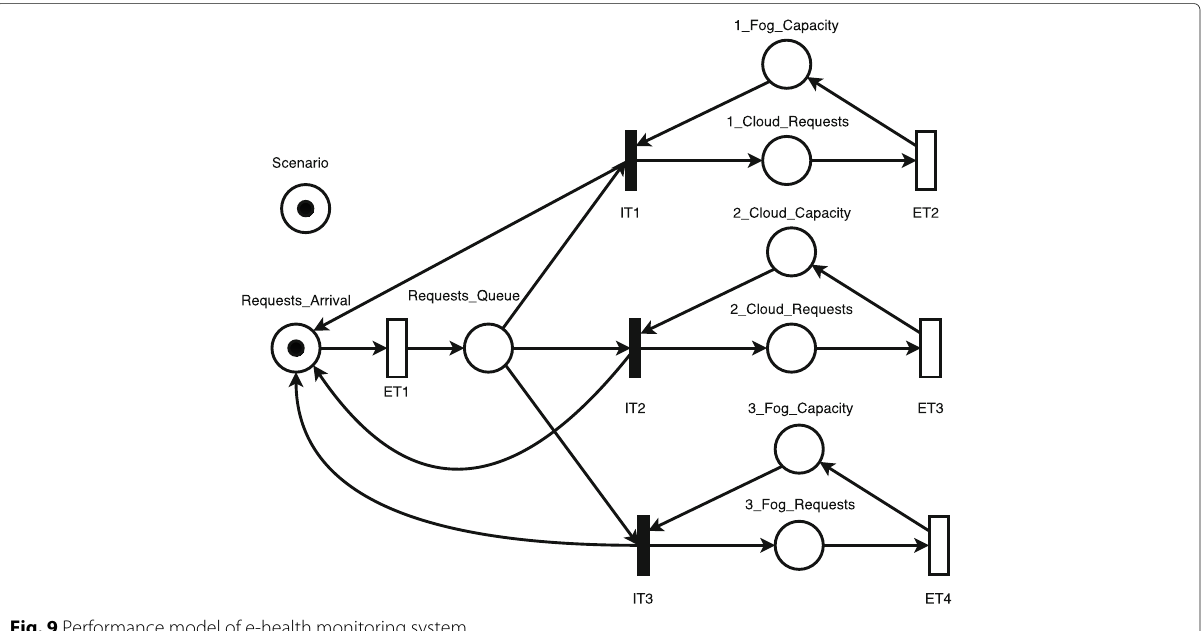
Fig. 9 Performance model of e-health monitoring